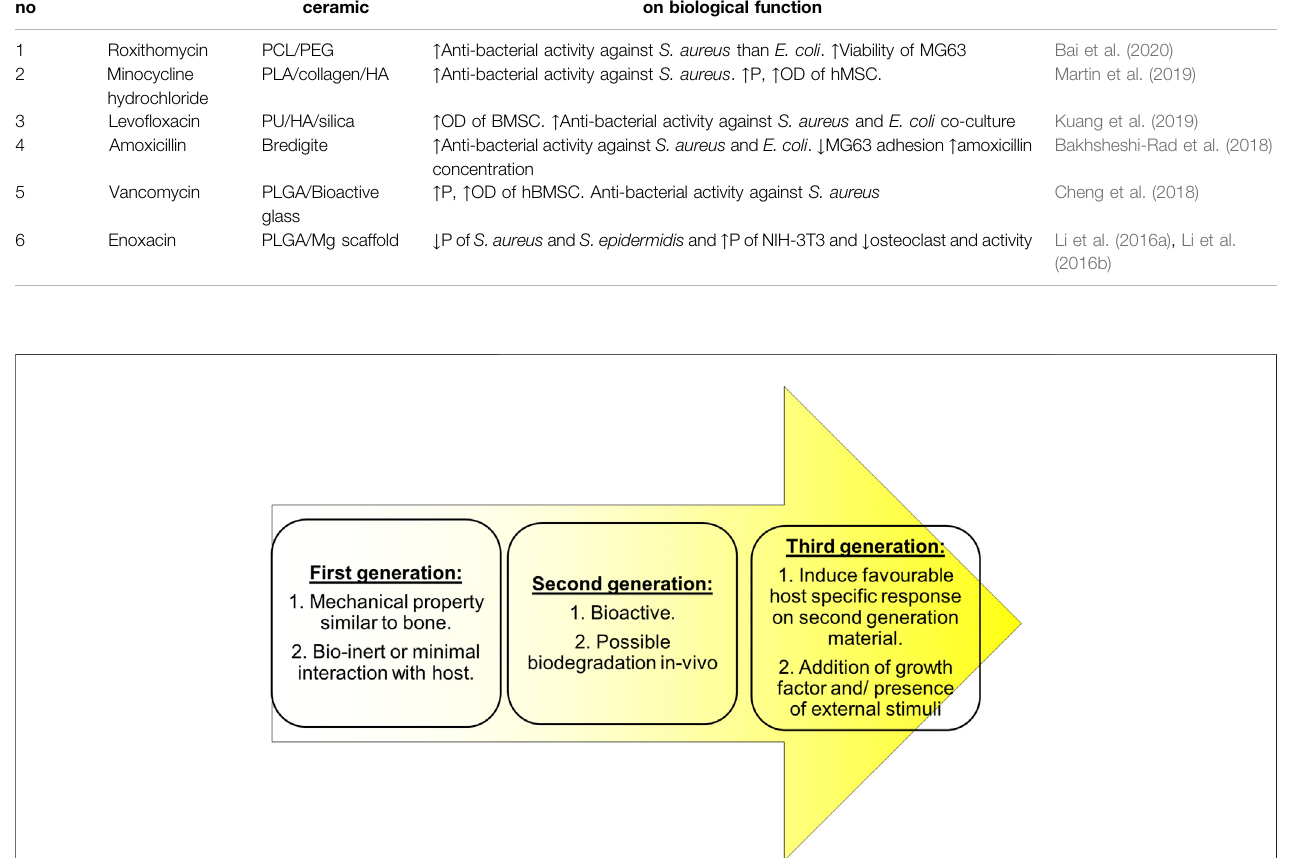
TABLE 1 | Effect of antibiotics used in scaffold towards osteoblasts and microbes function. S.